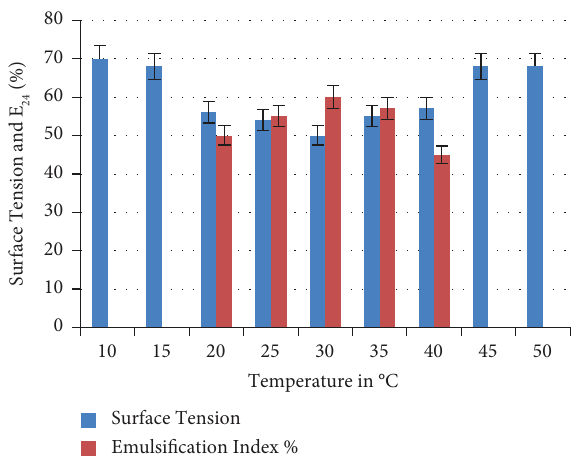
Figure 6: Efect of diferent pH values on biosurfactant production. pH 7 was the optimum with the highest E 24 % (60 ± 0.33%) and lowest surface tension 49 ±